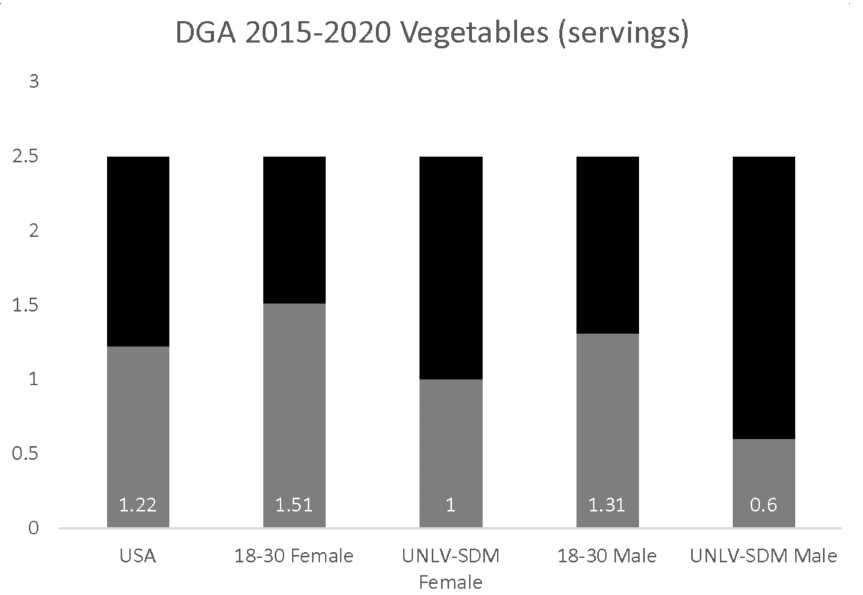
Figure 2. DGA vegetable consumption analysis. Analysis of UNLV-SDM dental students revealed significant differences, with consumption among females significantly higher than males, p = 0.022— although this was lower than the U.S. population in general and 18 to 30-year-olds, more specifically, p = 0.018, and did not meet the DGA